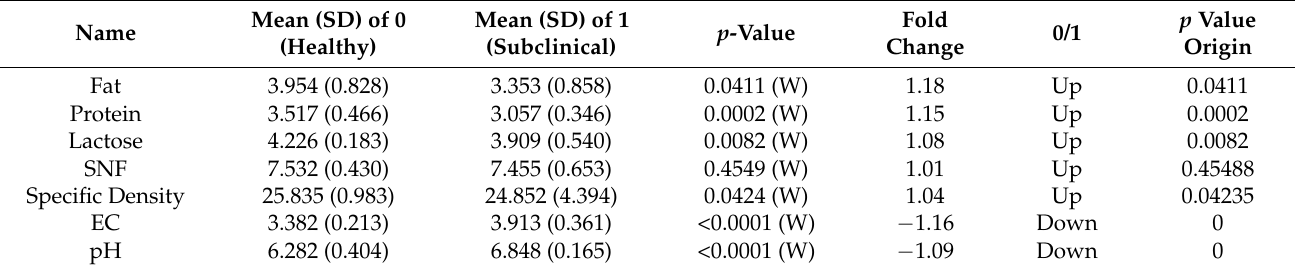
Table 5. Univariate analysis results for each